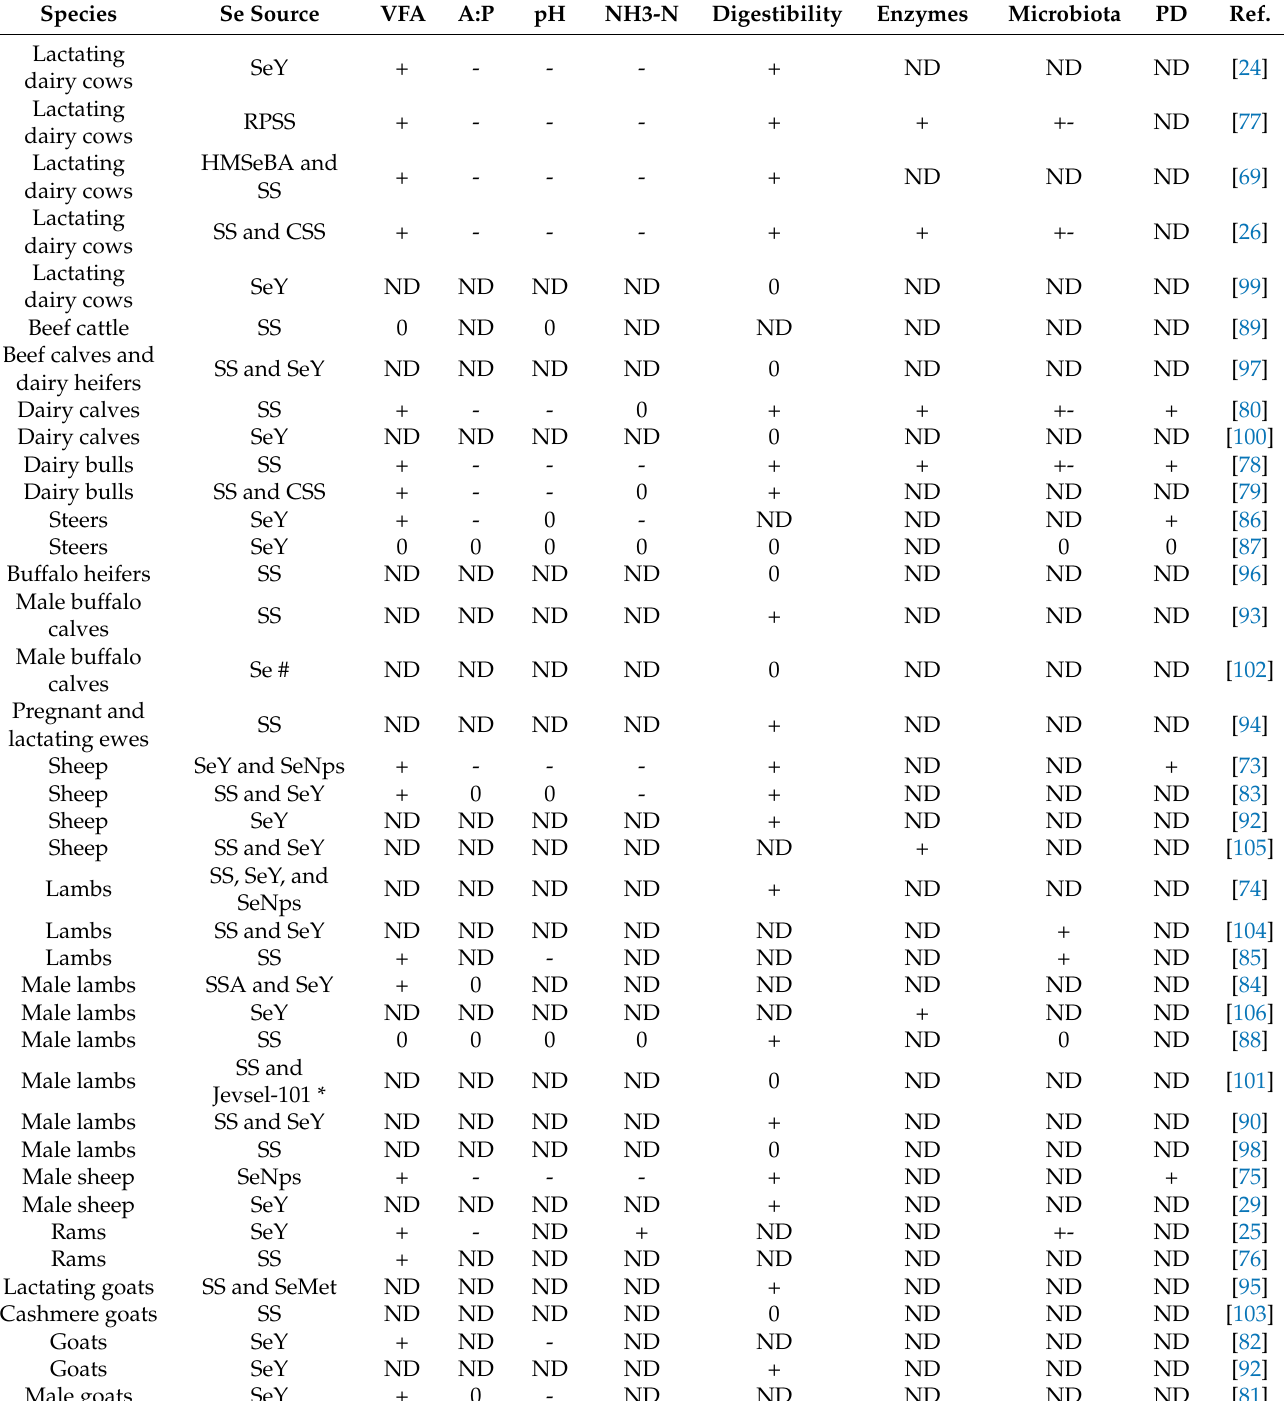
Table 1. Effects of different sources of Se supplementation on different farm